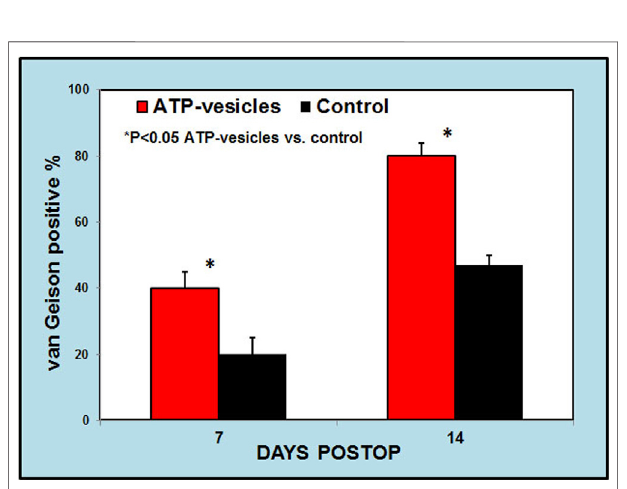
FIGURE 7 | A. Morphometric analysis of collagen to total wound bed ratiobyvanGiesonstaining.Thisanalysisindicateshighercollagencontentsin ATP-vesicle treated wounds than in cream-treated controls at day 7 and day 14. (Mean ± SD of six independent experiments p < 0.05).